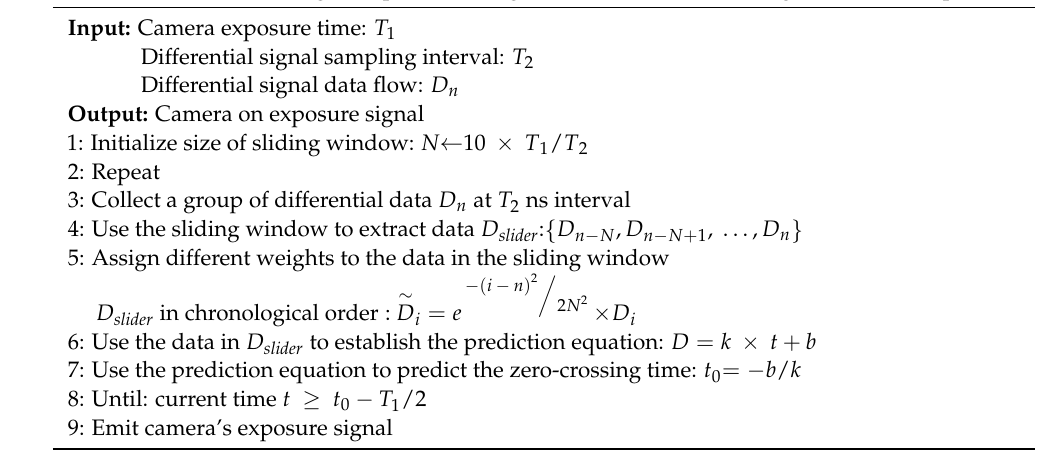
Figure 3. Schematic depicting the sliding-window concept. Data in the window are automatically updated as time progresses, and they are assigned different weights according to the order of collection. Algorithm 1. Zero-crossing time prediction algorithm based on the sliding window